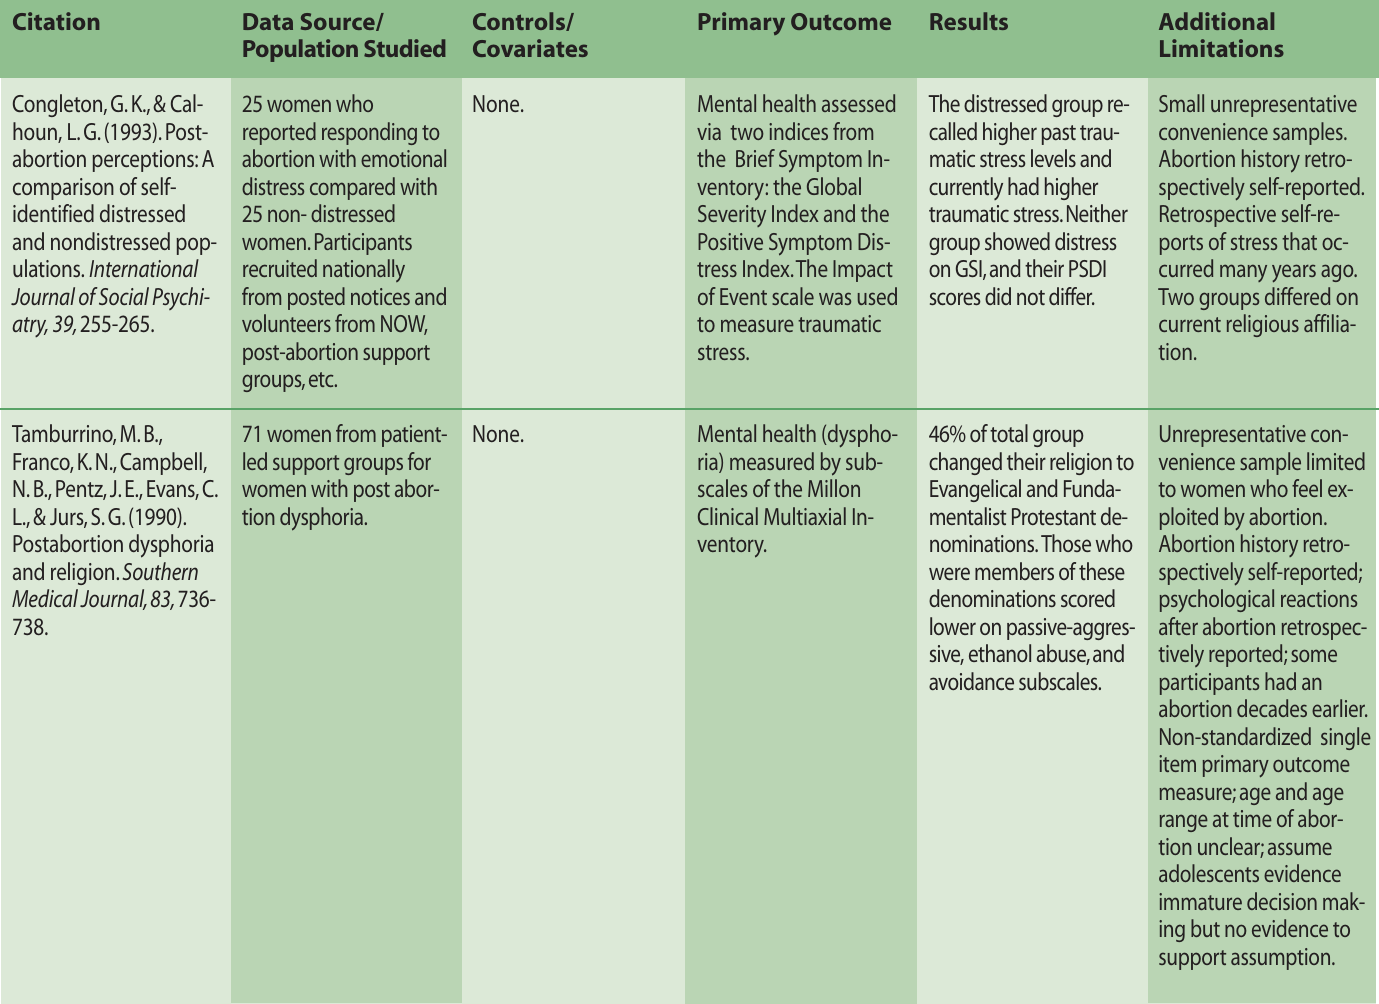
Table 5: U.S.Samples of Abortion Group(s) Only/No Comparison (continued) Retrospective Studies (all these studies lacked a preabortion measure of psychological